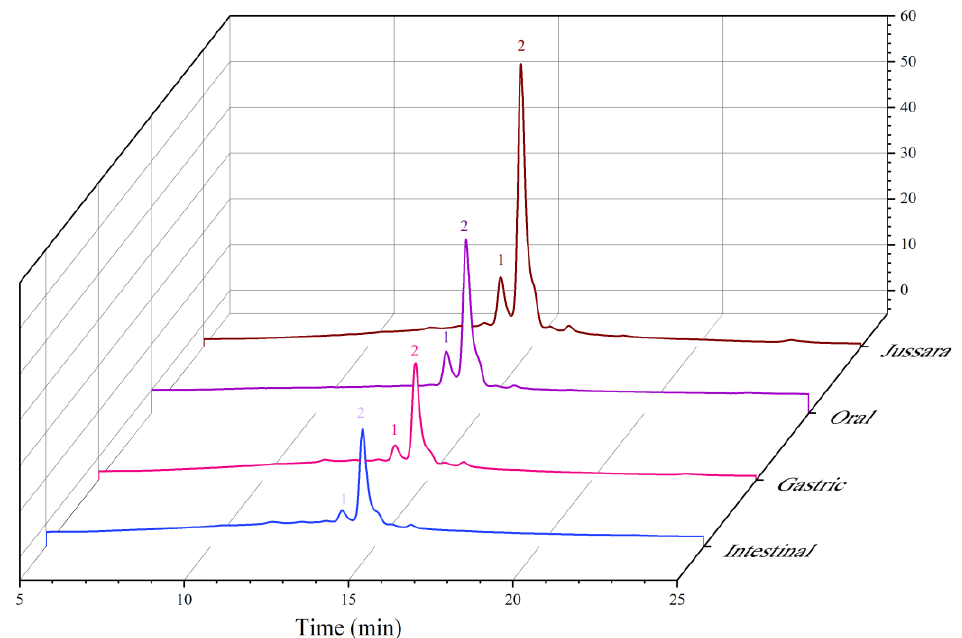
Figure 2. Chromatograms represent the anthocyanin profiles of the jussara pulp, initially and during the in vitro digestive process (oral, gastric, and intestinal). Peak 1 refers to cyanidin 3-rutinoside, and peak 2 refers to cyanidin 3-glucoside.